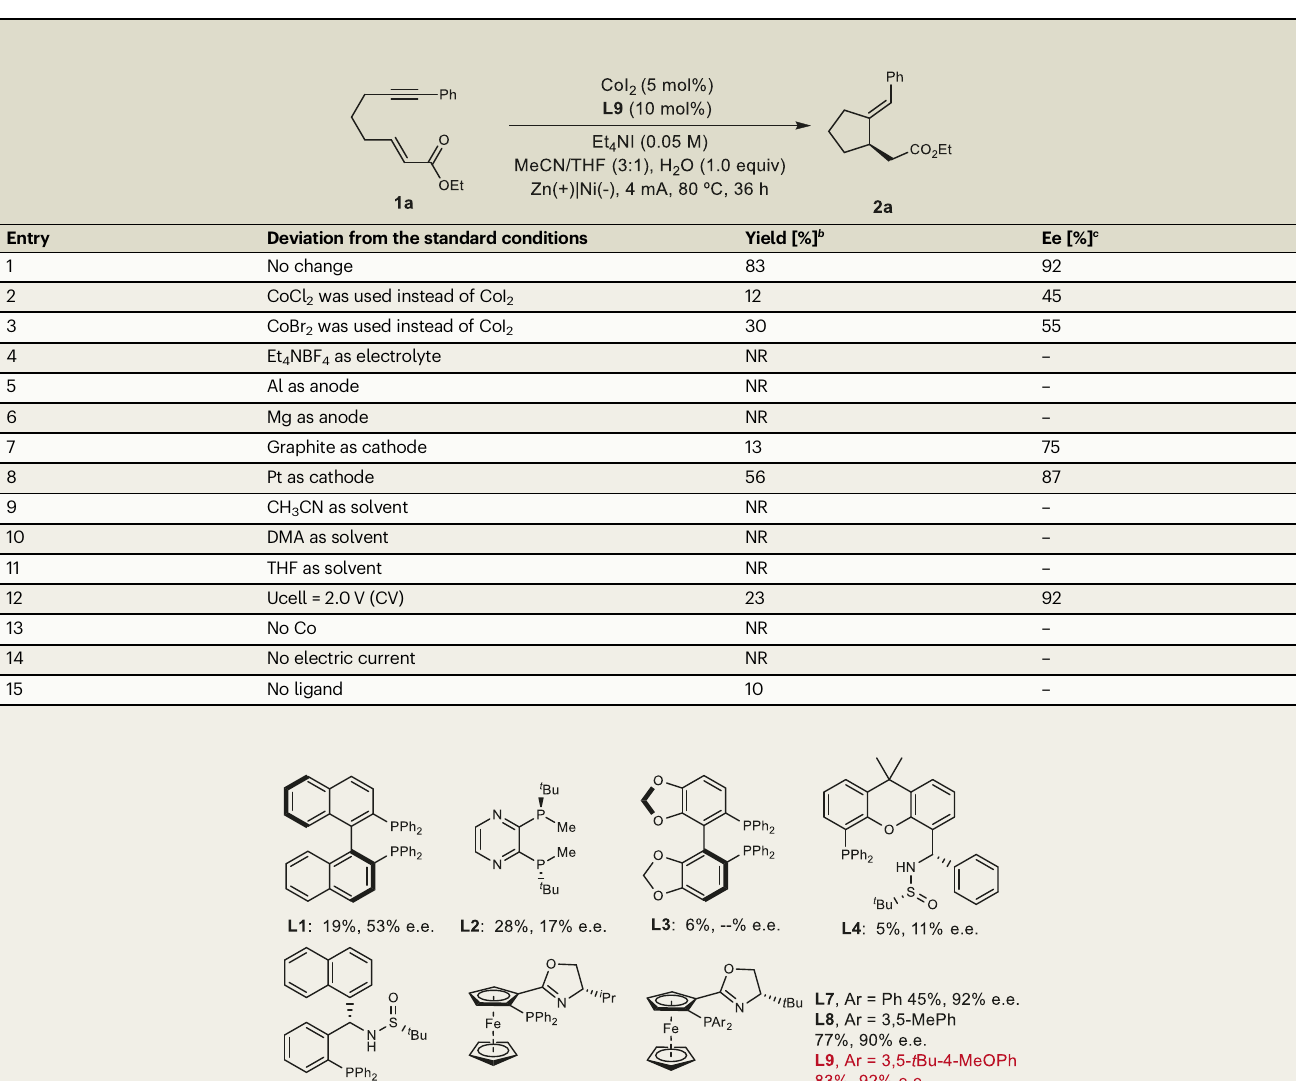
Table 1 | Reaction